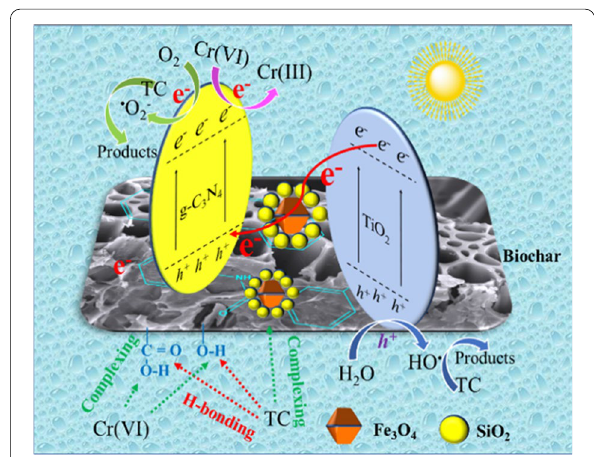
Fig. 7 The plausible removal mechanism of TC and Cr(VI) by